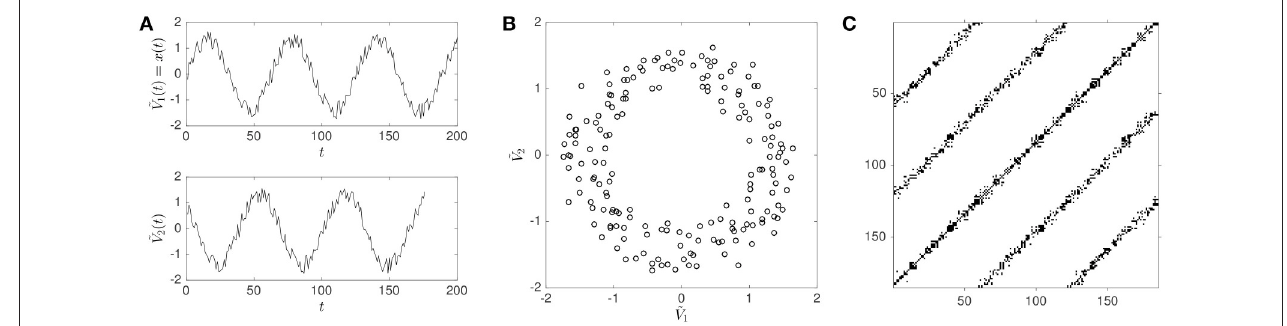
FIGURE 1 | Illustration of phase-space reconstruction and resulting RP using a noisy sine-wave. A noisy sine-wave in the upper panel of (A) and its time-shifted copy (surrogate) in the lower panel of (A) . Reconstructed phase-space portrait (B) , obtained by plotting the original sine-wave ˜ V 1 against its time-delayed copy ˜ V 2 . Resulting RP (C) , where diagonal lines of recurrences (black dots on the plot) indicate that the sine-wave signal repeats itself at intervals of roughly 60 data points. The speckled appearance of the diagonal lines indicates that repetitions are not perfect (i.e., the presence of